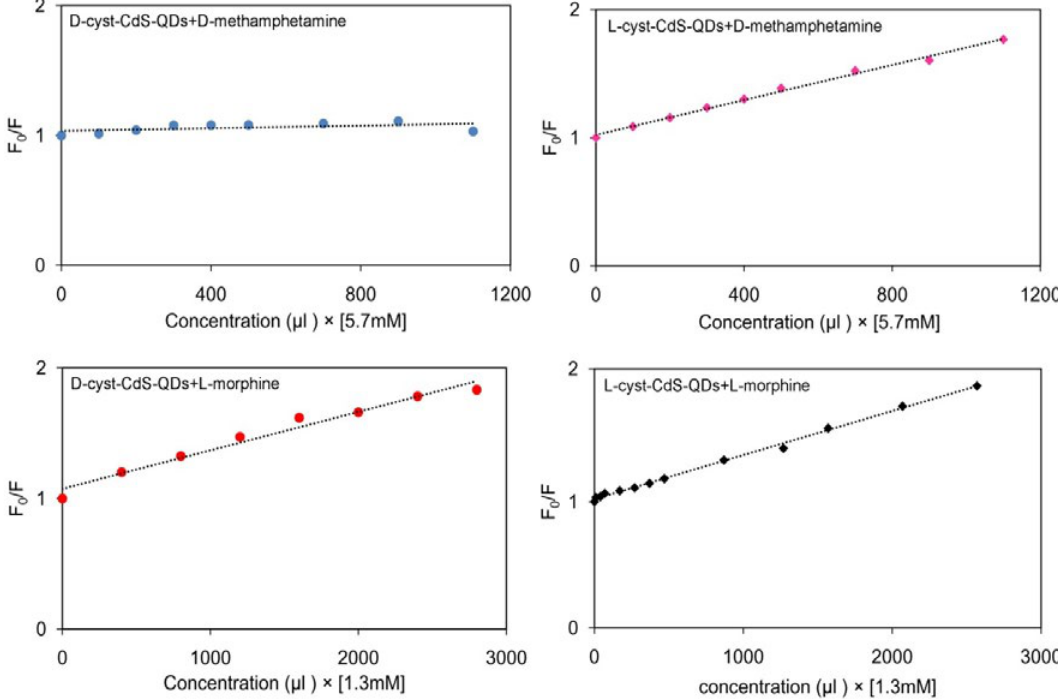
Fig. 9. Stern-Volmer plots of interaction between L- and D-cyst-CdS-QDs and L-morphine and D-methamphetamine.